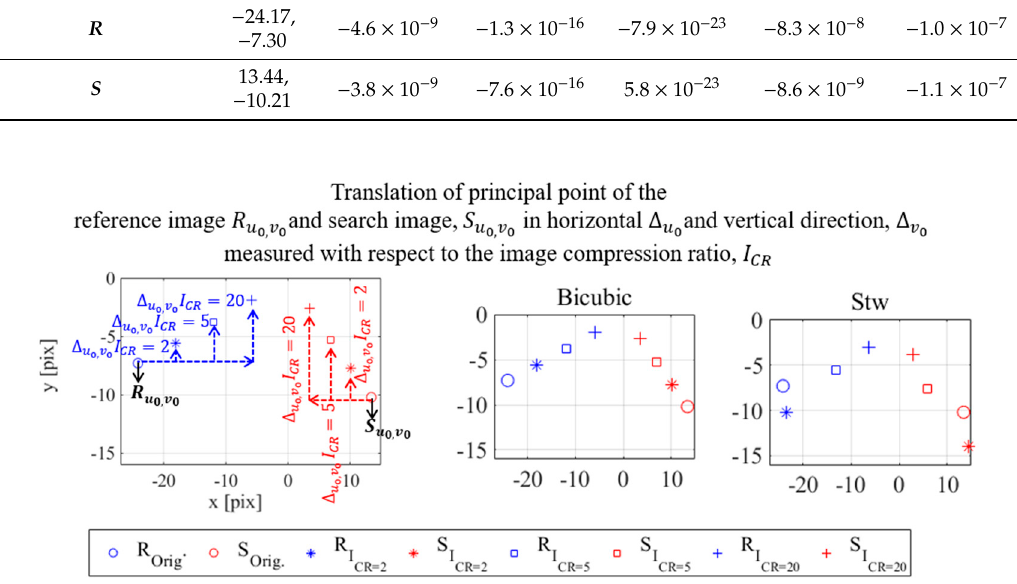
Table 3. Principal point translation ratios (calculated as shown in Figure 10) in horizontal ∆ (cid:3048) directions for different image compression methods and compression ratios vertical ∆ (cid:3049) (cid:3116) Method